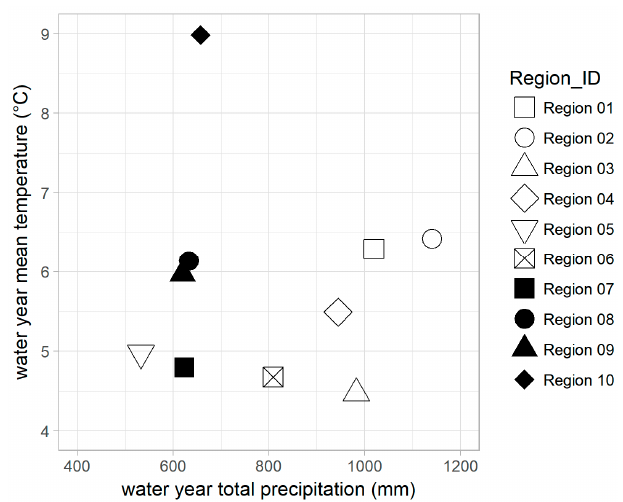
Figure 3. Average water year total precipitation versus average water year temperature of each study region. Hollow symbols are for regions in the Northwest, and solid symbols are for regions in the Southwest. Averages were computed for the period 1997–2015. Forests 2019 , 10 , x FOR PEER REVIEW